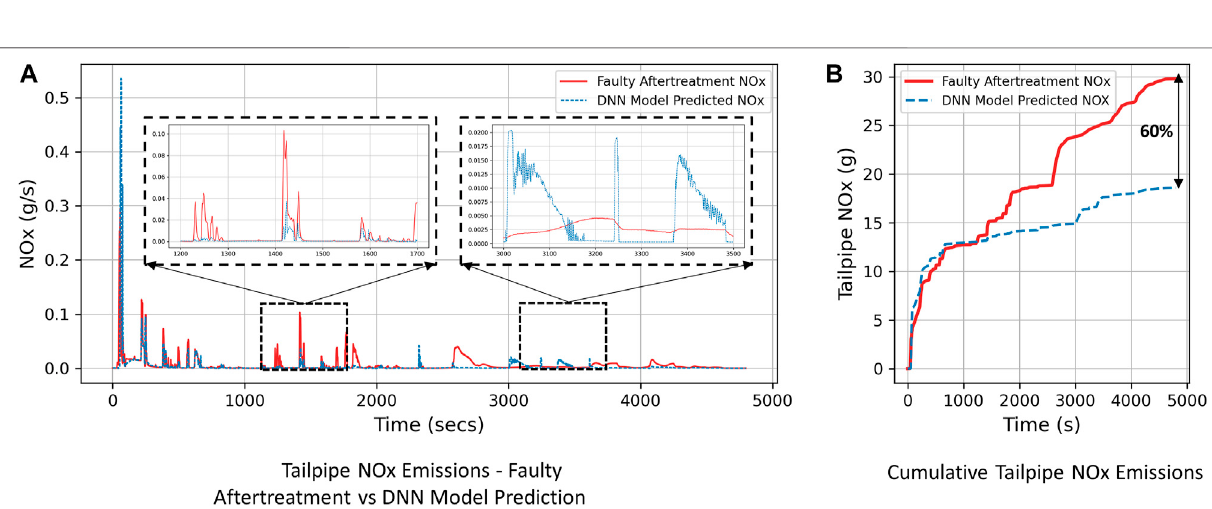
Frontiers in Mechanical Engineering |